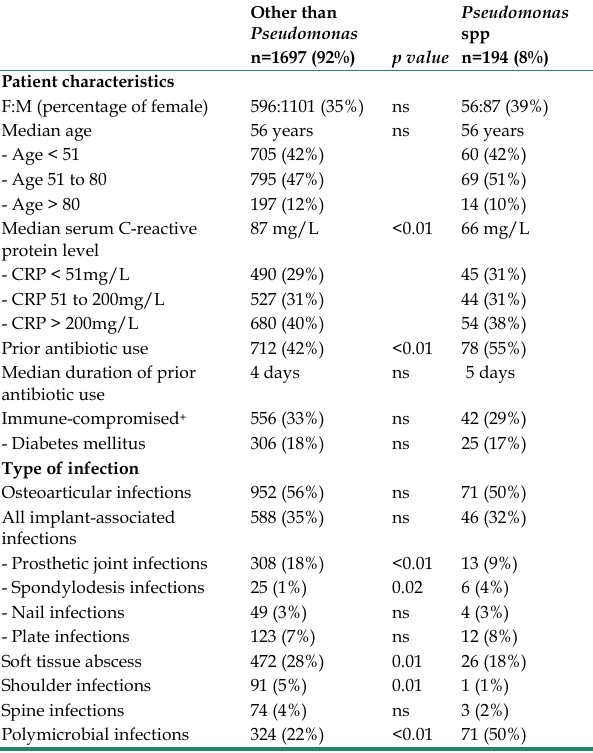
Table 3 . Comparison of orthopedic infections due to Pseudomonas spp versus other pathogens.